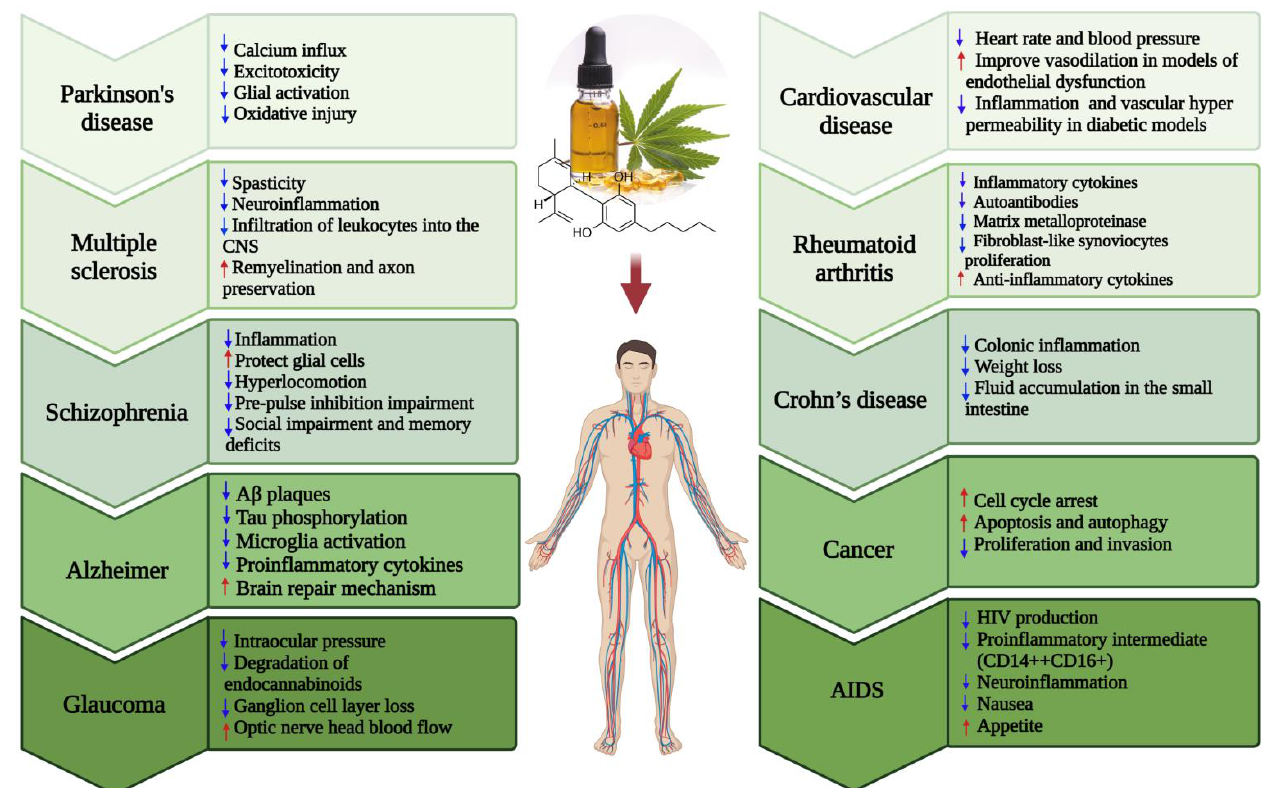
Figure 1. Various diseases against which cannabis/cannabinoids have potential for prevention and treatment (up and down arrows indicate increase and decrease respectively).